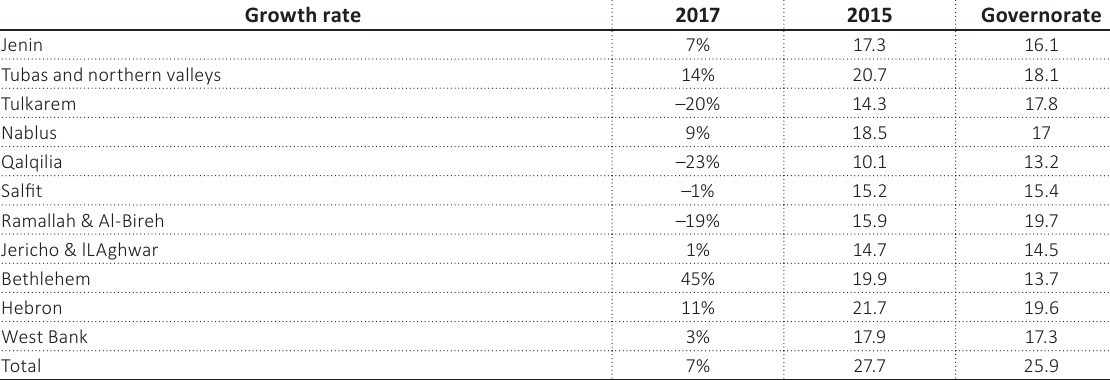
Table 2. Unemployment in Palestine by